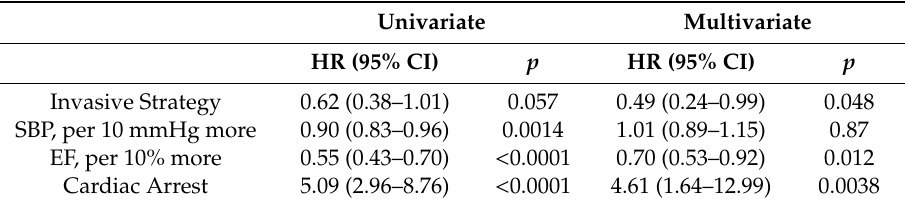
Table 4. Univariate and multivariate analysis .